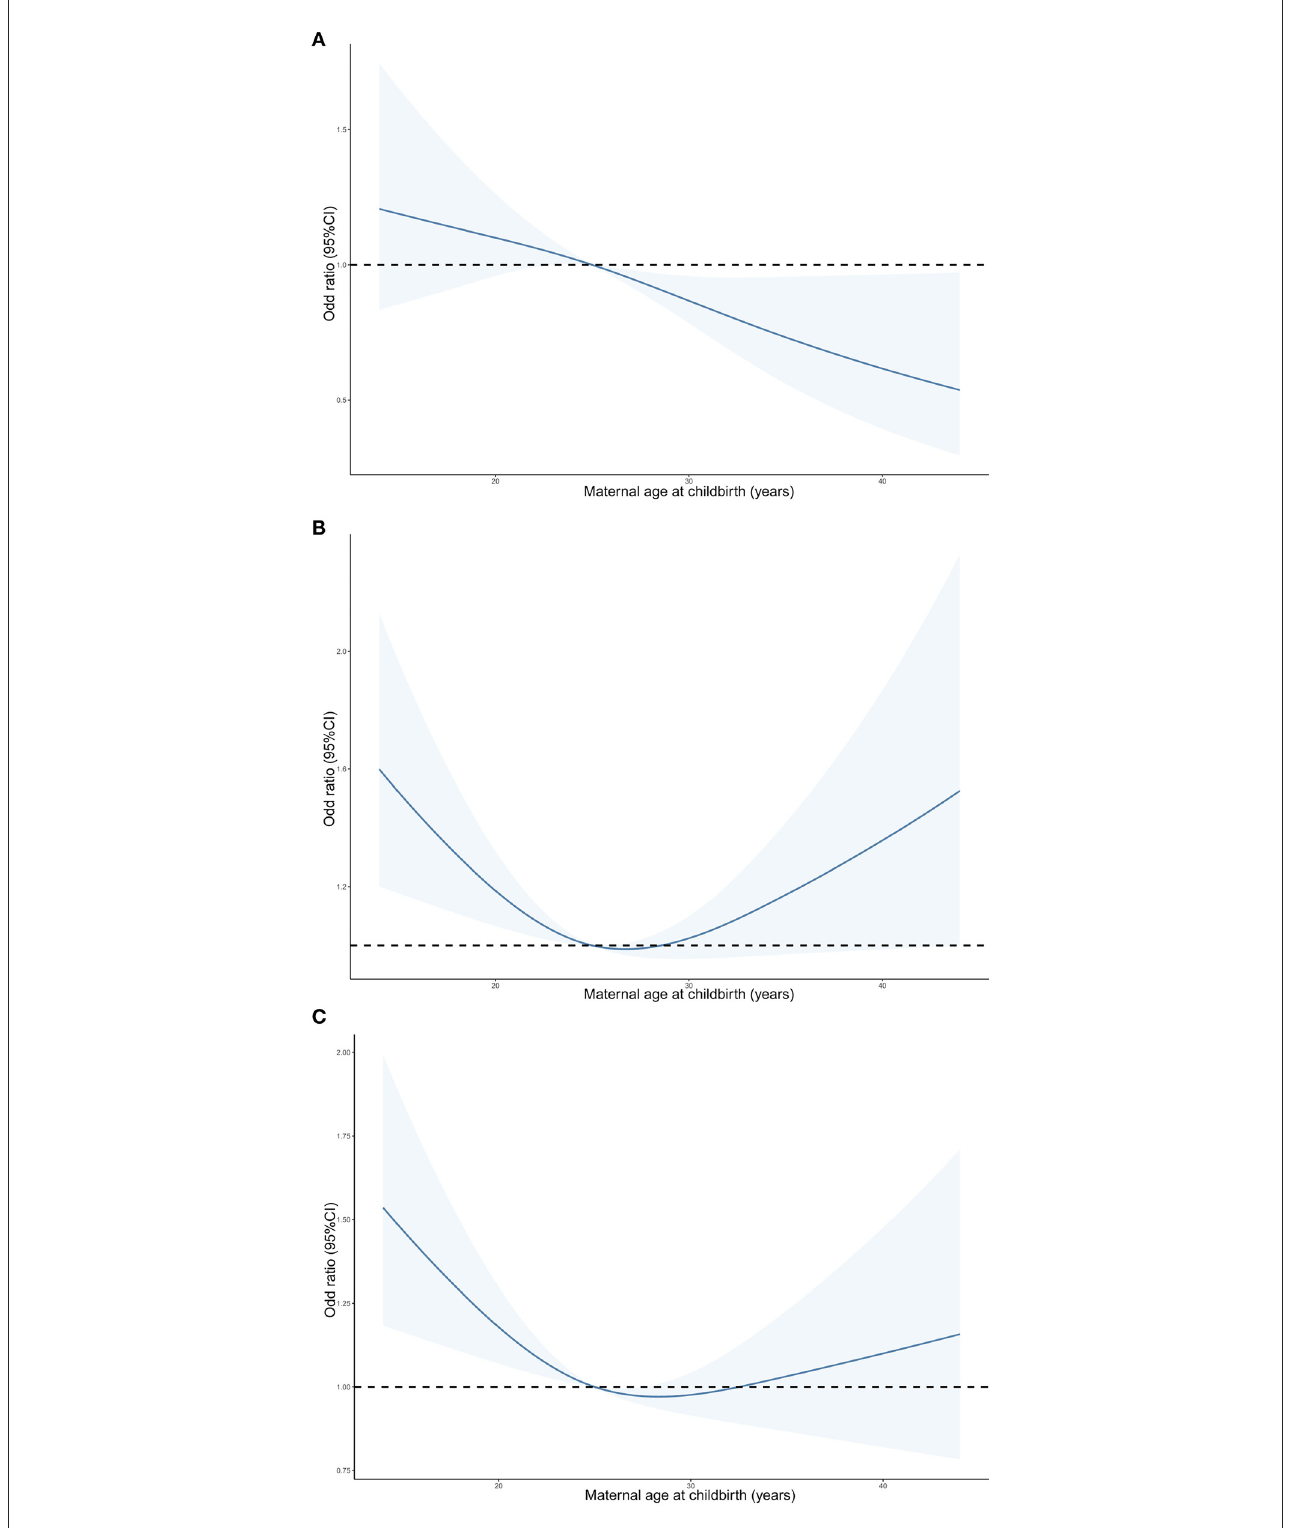
FIGURE2 Predicted spline curves for the associations of maternal age at childbirth with the risk of ADHD (A) , LD (B) and either ADHD or LD (C) in offspring according to RCS regression models. ADHD, attention-deficit/hyperactivity disorder; LD, learning disability.